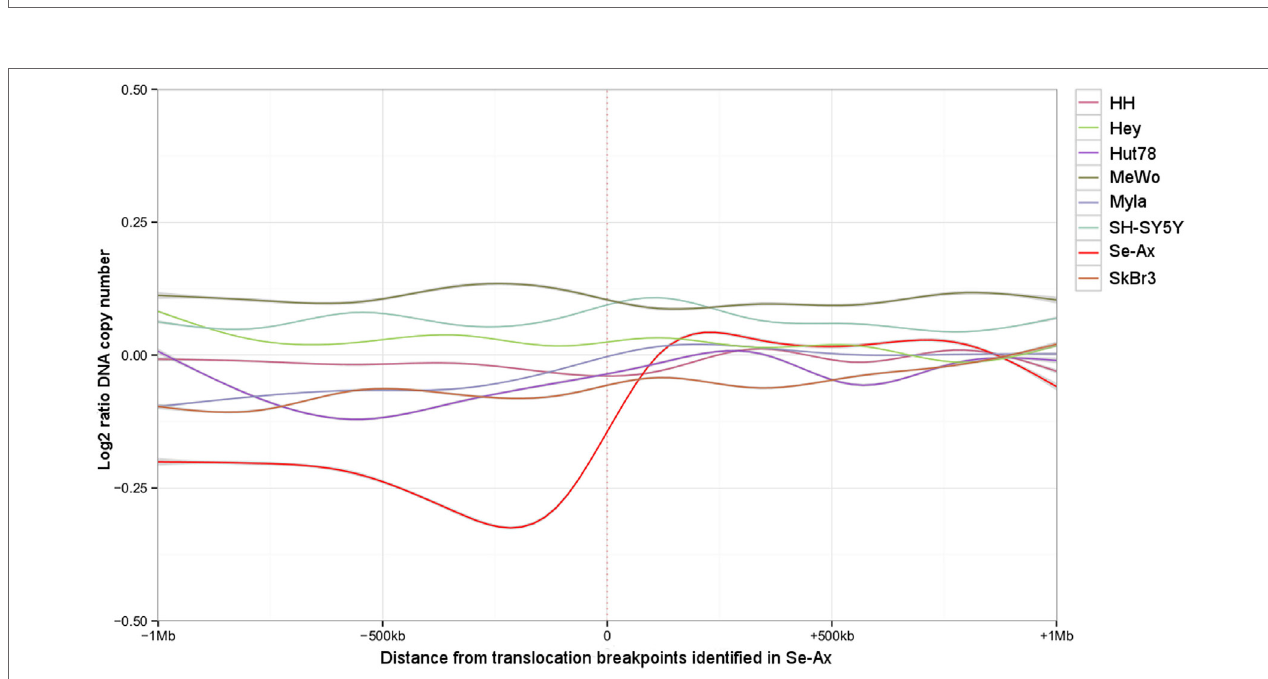
FigUre 4 | Deletions adjacent to the translocation breakpoints identified in Se-Ax. Smoothed log2 ratios of DNA copy number within a 2 Mb interval surrounding the translocation breakpoints are shown for Se-Ax (red line). DNA copy numbers of additional cell lines for the very same intervals are displayed for comparison (see insert box for color